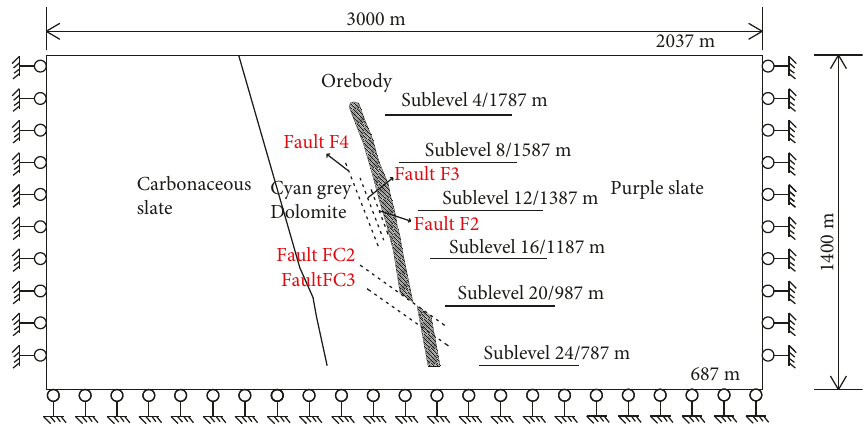
Figure 2: Distribution diagram of fault and orebody.